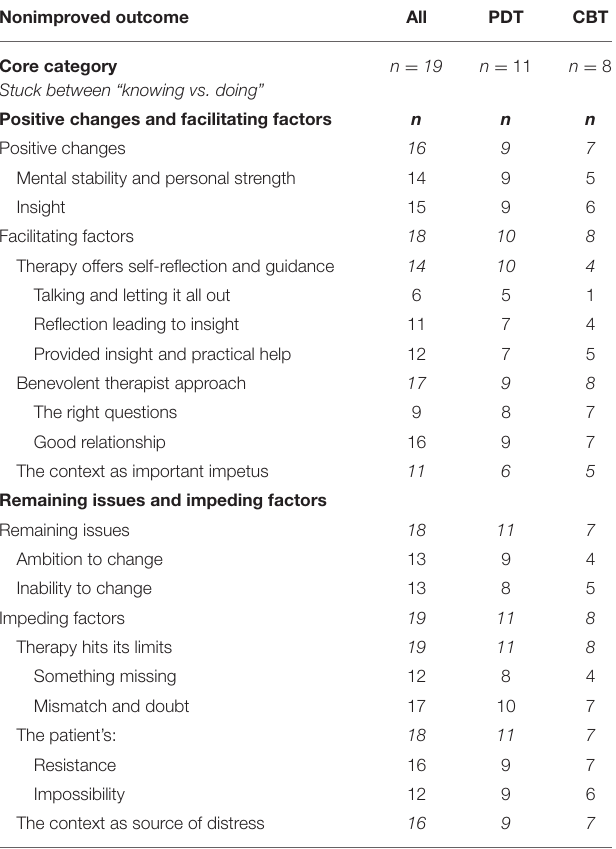
TABLE 3 | Taxonomy of non-improvement based on depressed patients’ perspective. Nonimproved